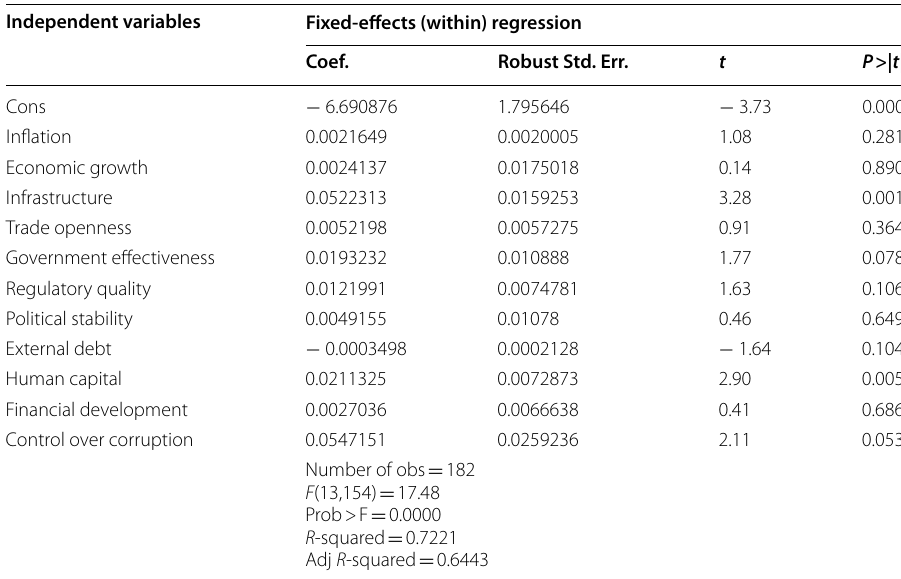
Table 2 Fixed effect regression output Dependent variable: inflow of foreign direct investment as percentage of